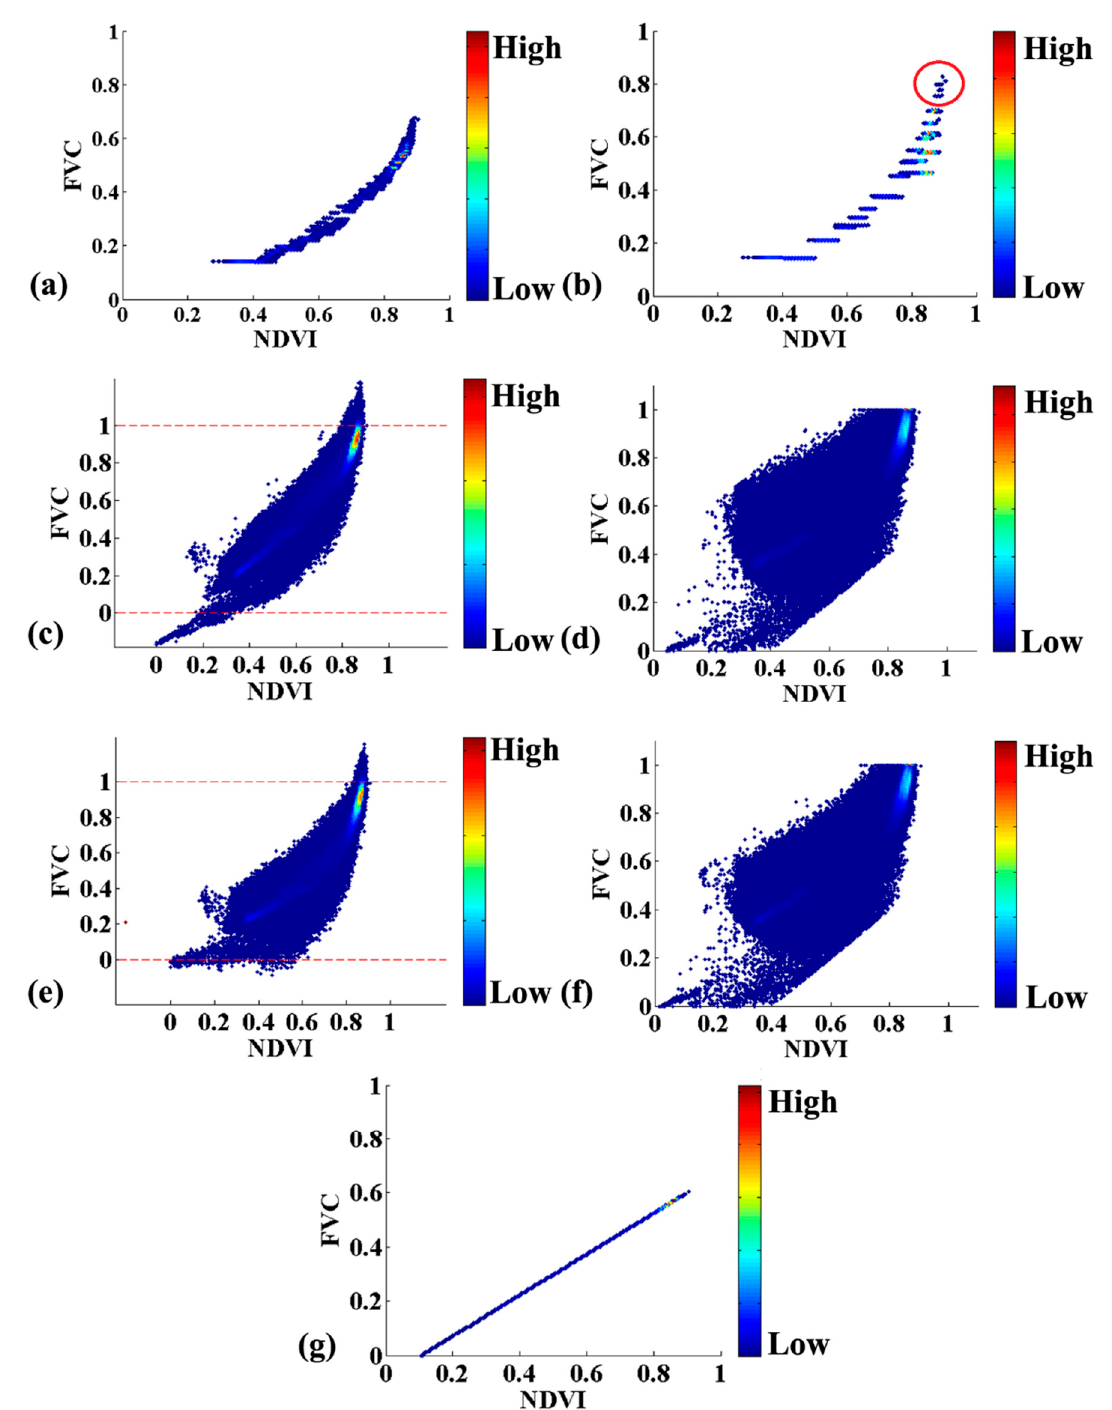
Figure 5. The density plots of the relationship between NDVI and FVC estimated from different algorithms in the World-View 3. ( a ) MFS+BPNN, ( b ) PROSAIL+BPNN, ( c ) U-SMA-2, ( d ) C-SMA-2, ( e ) U-SMA-5, ( f ) C-SMA-5, and ( g ) empirical method.